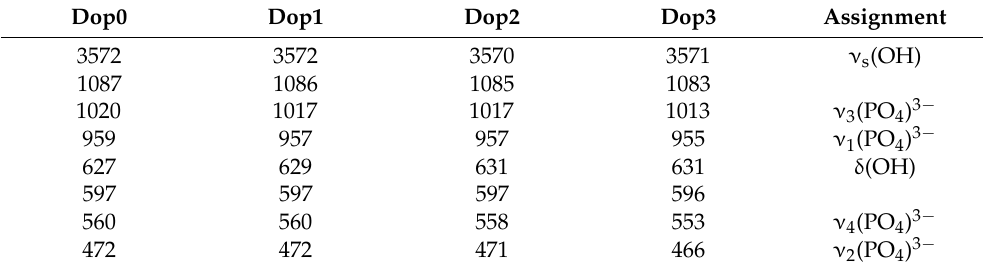
Table 5. FTIR band positions (wavenumbers, cm − 1 ) and relative assignments for Sr-doped and undoped HAp